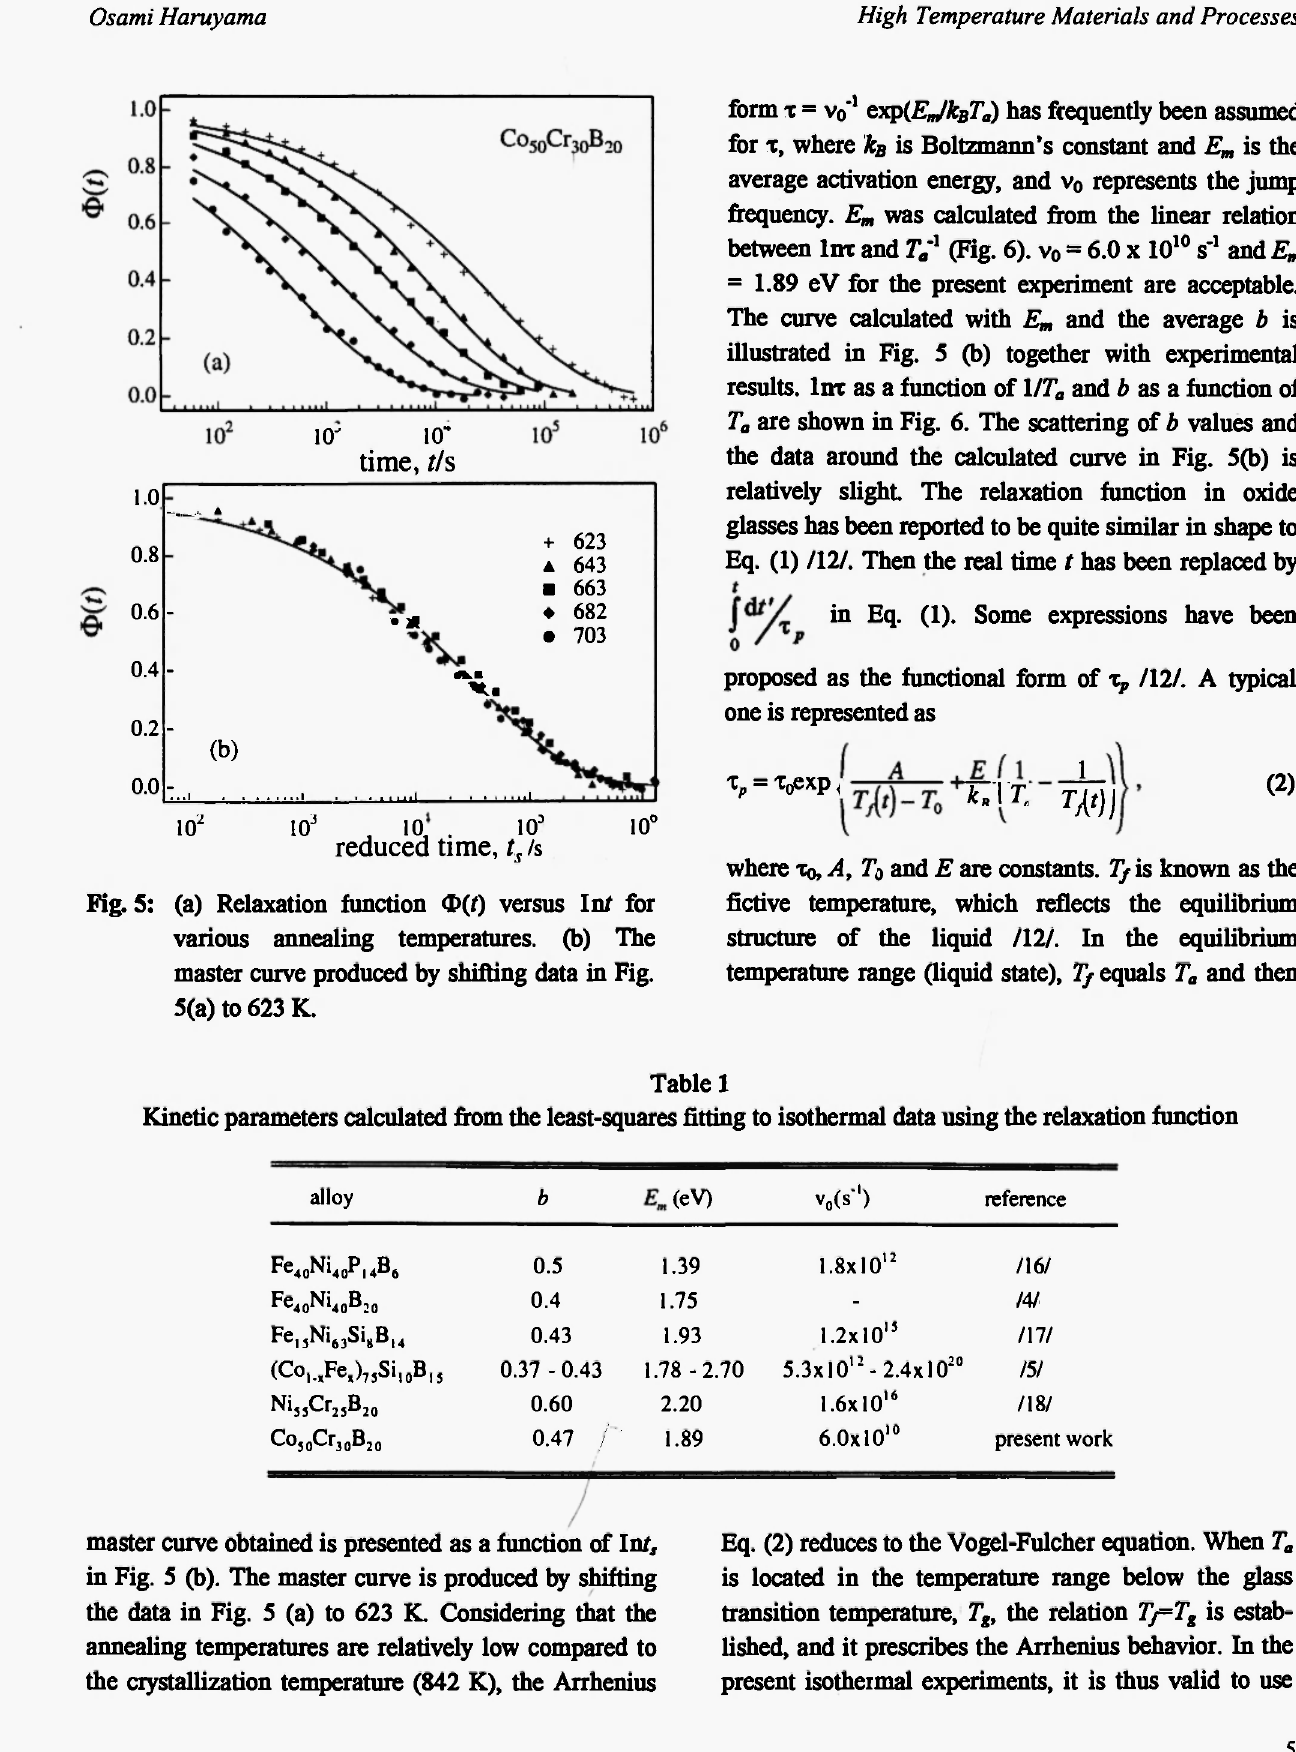
Kinetic parameters calculated from the least-squares fitting to isothermal data using the relaxation